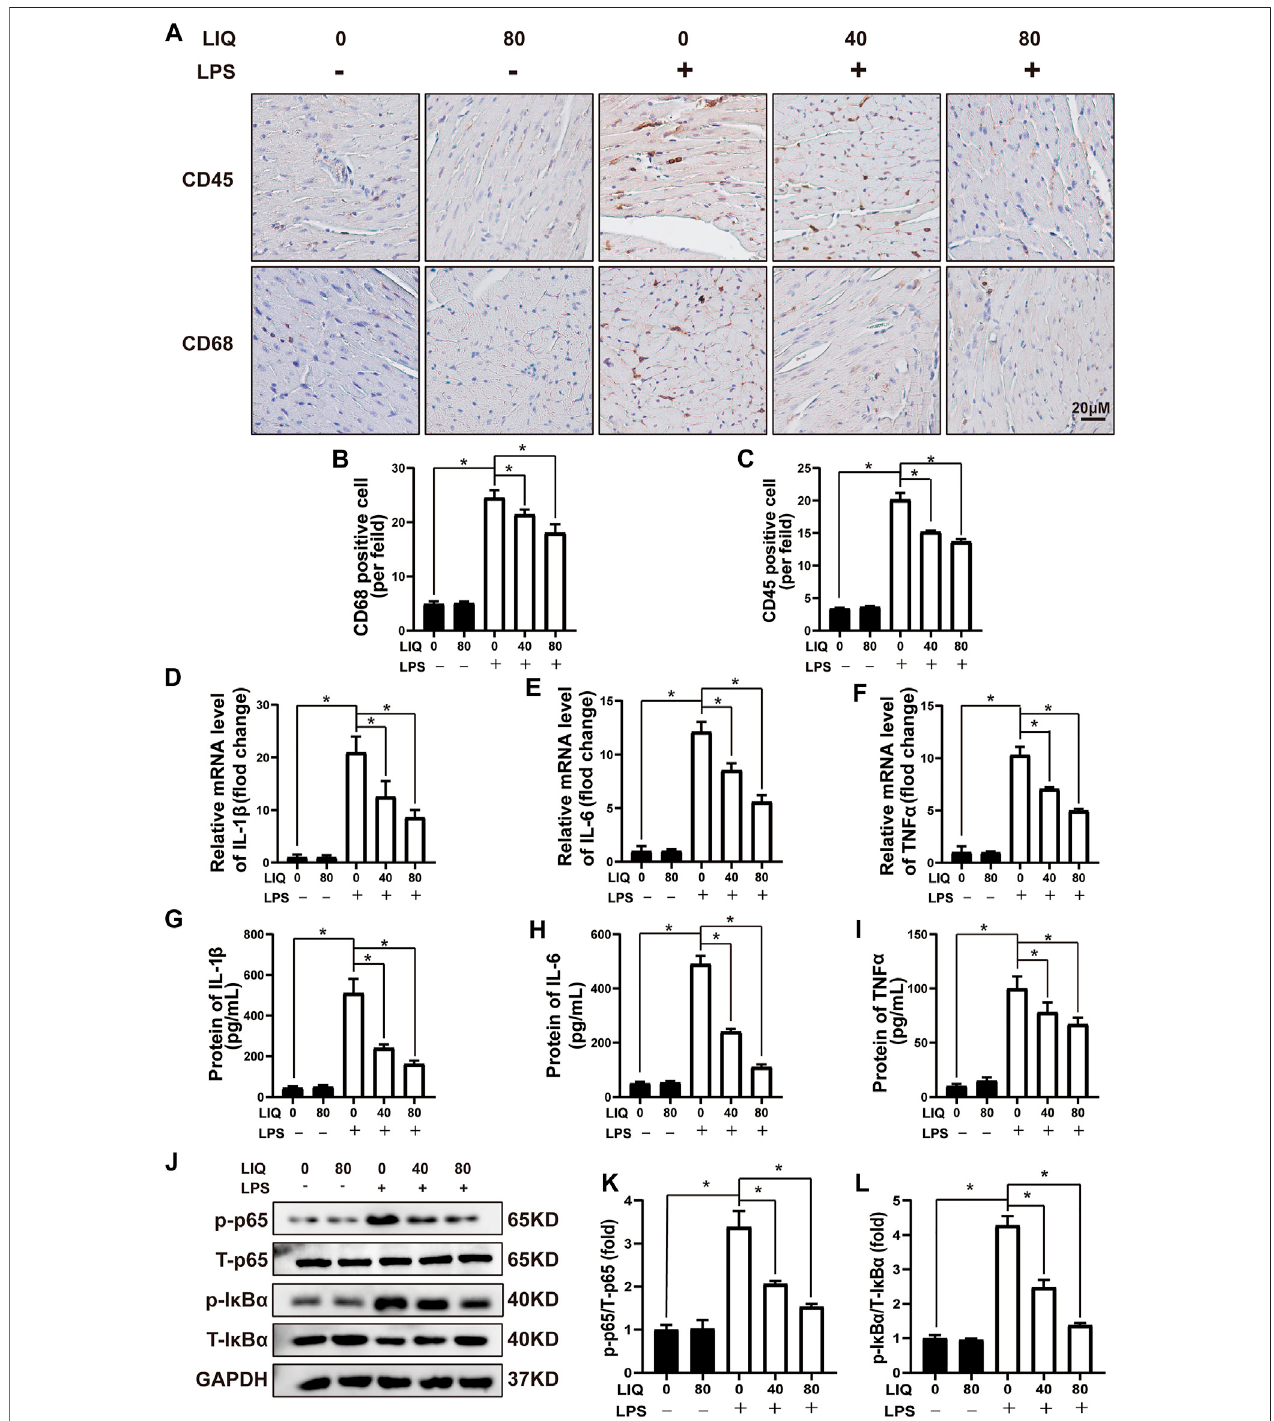
FIGURE2| LIQtreatmentsuppressedLPS-inducedcardiac in fl ammation in vivo (A) Immunohistochemicalstainingwasperformed todetect CD-45and CD-68 in mouse left ventricle ( n (cid:2) 6), (B,C) Counting CD68 and CD45 positive cells ( n (cid:2) 6), (D – F) RT-PCR was performed to examine mRNA expression of IL-1 β , IL-6 and TNF α ( n (cid:2) 6), (G – I) ELISA was performed to detect proteins expression of including IL-1 β , IL-6 and TNF α ( n (cid:2) 6), (J – L) Representative western blots and relative quantitative resultsofproteinsinNF- κ Bsignalingpathway,includingphosphorylatedP65(p-P65),totalP65(T-P65),p-I κ B α andT-I κ B α ( n (cid:2) 6).Miceweretreatedwithadoseof 10 mg/kgLPS,thedataareexpressedastheMean ± SEM. p p < 0.05comparedwiththeindicatedgroup.Thedatawerecomparedbyone-wayANOVAwithTukeypost hoc